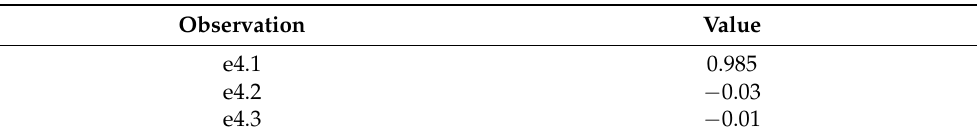
Table 4. Assignment of particular values for h4. Prepared by the authors as an example. Prepared by the authors on the basis of [2,53,57,58].